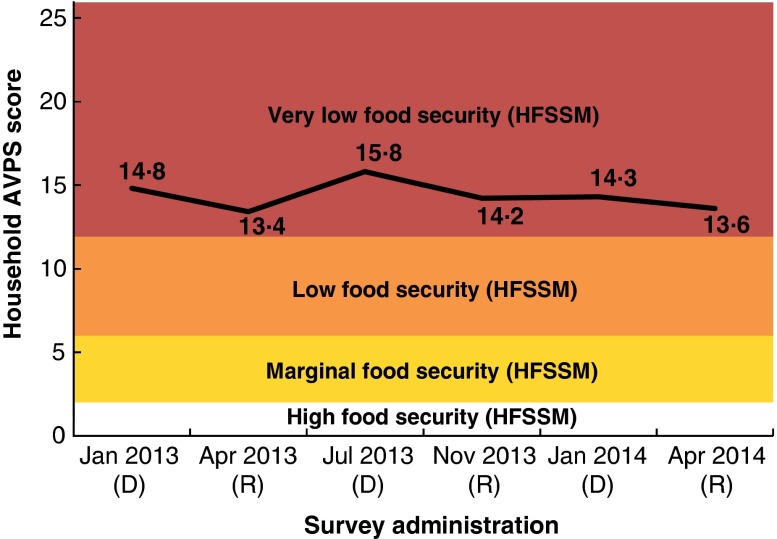
(colour online) Mean Adapted Vulnerable Populations Score (AVPS) by season (D, dry;
R, rainy), compared with Household Food Security Survey Module (HFSSM)
categorizations, in Batwa Pygmy households (n 130) from ten rural
Indigenous communities in Kanungu District, Uganda, January 2013–April 2014. Figure
demonstrates why variation between seasons was not detectable using the HFSSM:
variation occurred only within the most severe category of food insecurity. The
black line denotes the mean AVPS across surveys